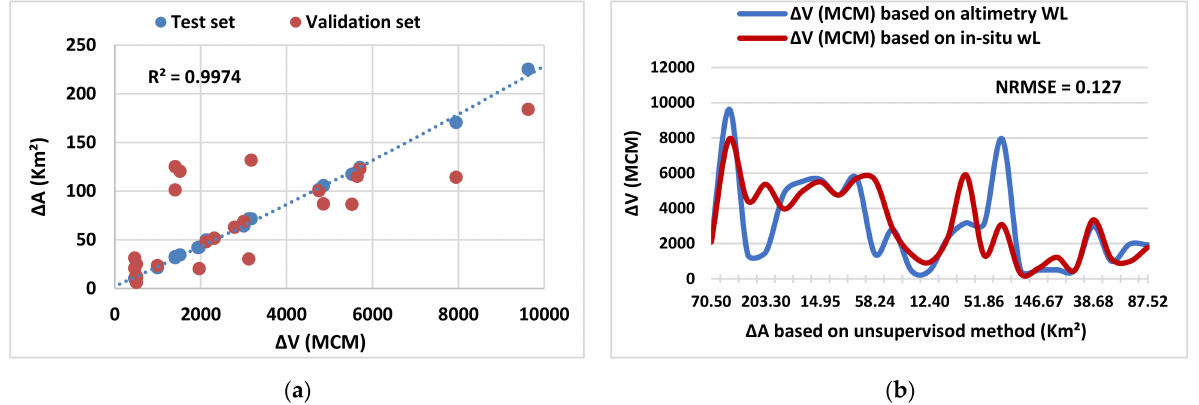
Figure 15. Relation between water surface area variation and volume variation of AHDL. ( a ) Result of correlation between estimated ∆ V by Sentinel-3 altimetry water level in MCM and ∆ A in Km 2 ”Test set” and “Validation set” estimated ∆ V by in situ water level in X axis. ( b ) Water volume variations estimated by the Heron method over a time period and during variation in water surface area with NRMSE value between test set and validation